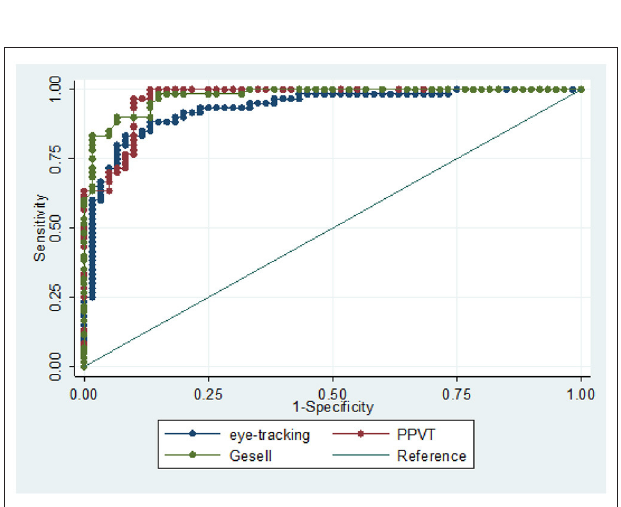
FIGURE 4 | ROC curve analysis of diagnostic performance of the eye-tracking technology, PPTV, and Gesell scales to distinguish children with GDD from